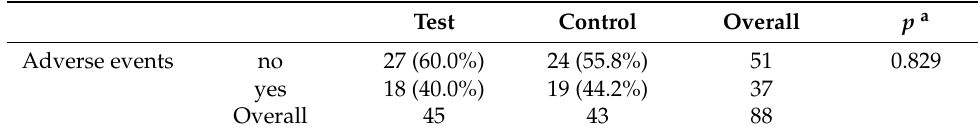
a Chi-squared test.